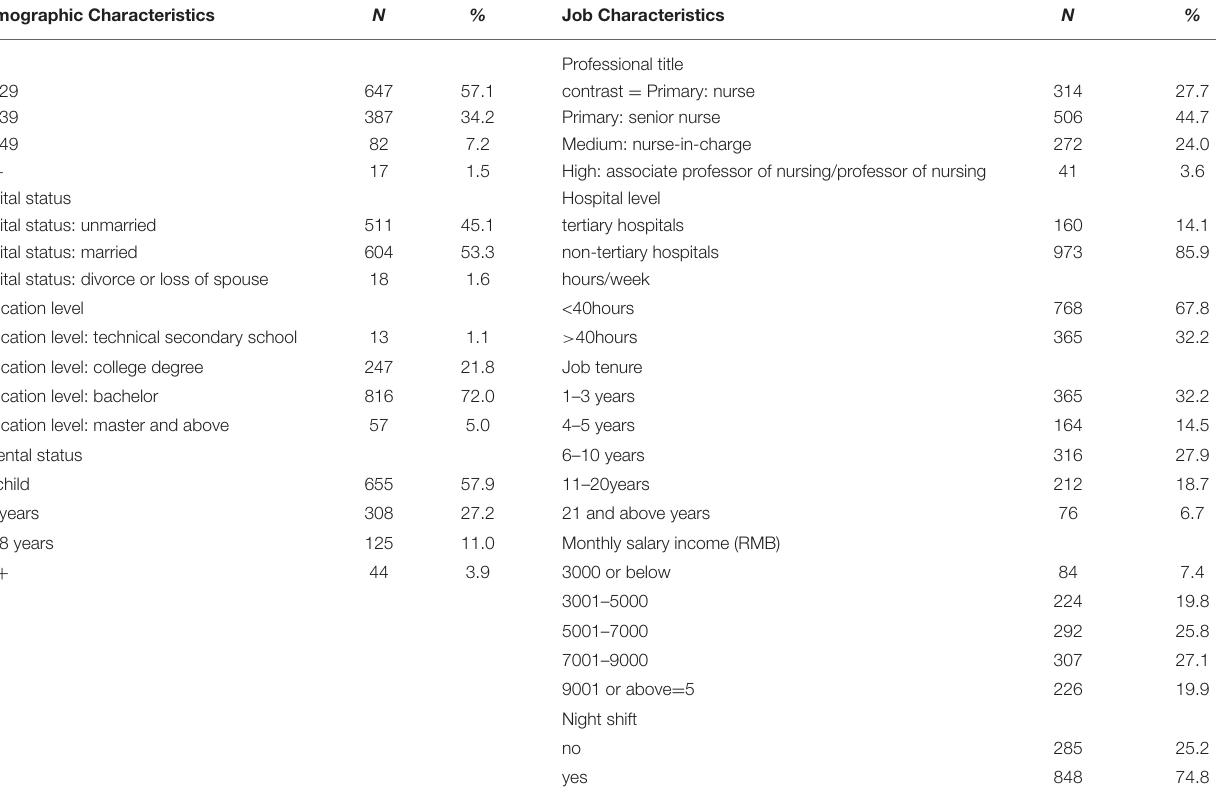
TABLE 2 | The list of demographic and job characteristics of the participants. Demographic Characteristics